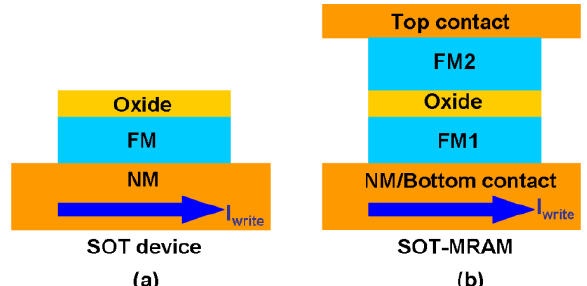
Figure 6. Schematic of ( a ) an SOT (‘spin-orbit torque’) device illustrating the write current path in the SOT scheme and ( b ) a SOT-MRAM cell utilizing the SOT scheme for writing and TMR (tunnel magneto-resistance) scheme for readout. FM and NM denote the ferromagnetic layer and non-magnetic layer, respectively. (Reprinted with permission from [71]).